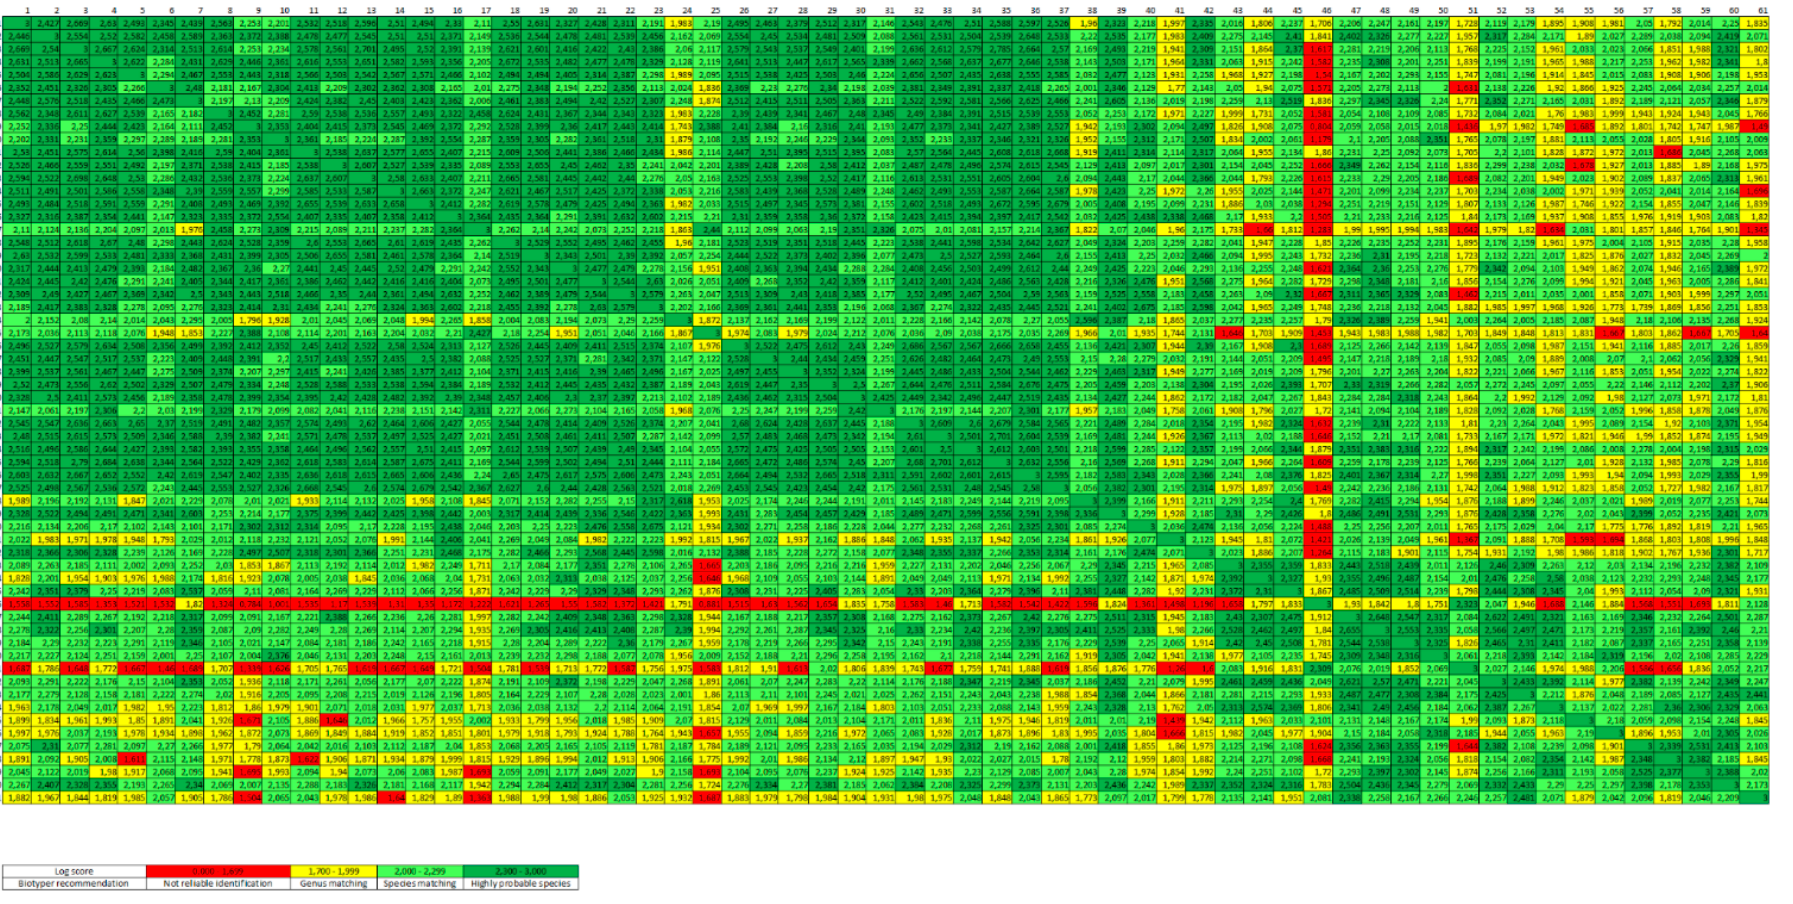
Figure 1. Heat map of 61 A. alata main spectra profiles (MSP) based on log scores. Each MSP represents one host individual. The presented figure is sorted by host species, country and region of origin. Nos 1 to 54 are wild boars, nos 55 and 56 are common frogs, nos 57 to 60 are water frogs and no. 61 is a lynx. Further information about the A. alata samples are listed in Table